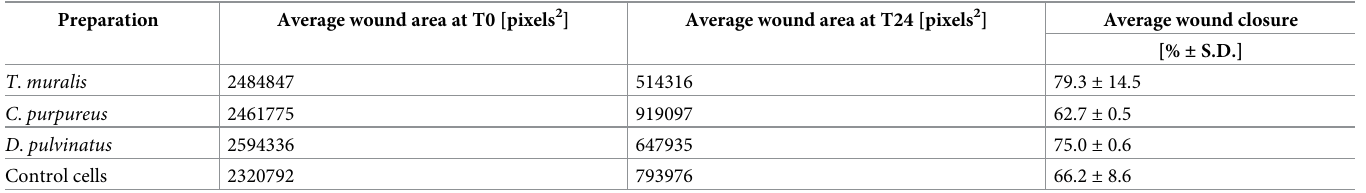
Table 5. The pro-regenerative potential of the moss extracts on human foreskin fibroblasts (HFF-1 line) tested in vitro by scratch assay.